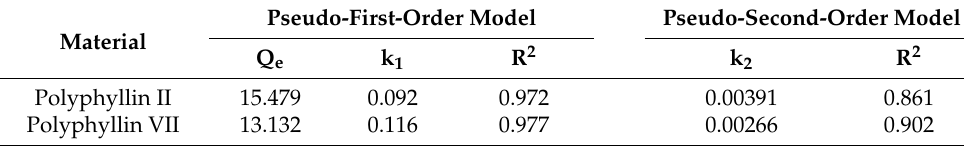
Table 8. Two model fitting parameters of dynamic data on